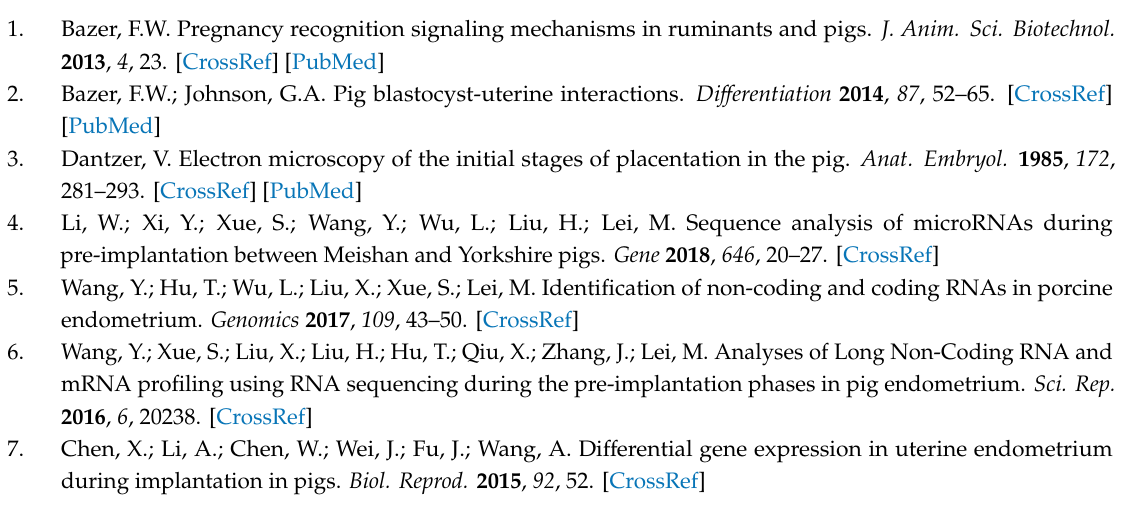
Table S1: Primer list of di ff erentially expressed genes and miRNAs validation, miRNA mimics sequences and scrambled sequence (NC) in dual luciferase reporter assays. Table S2: Raw data statistic of RNA-seq. Table S3: List of di ff erentially expressed genes between gestational days 12 and 15. Table S4: List of di ff erentially expressed genes between the two anatomical location (the mesometrial side and anti-mesometrial side of uterus). Table S5: List of di ff erentially expressed miRNAs between gestational days 12 and 15. Table S6: List of di ff erentially expressed miRNAs between the two anatomic location (the mesometrial side and anti-mesometrial side of the uterus). Figure S1: Validation of the predicted miR-142-3p-ITGB8 interactions with the dual luciferase reporter system. Author Contributions: All authors reviewed and approved the final version of the manuscript. M.Y. conceived and designed the experiments; J.H., Y.Y., and M.T. performed the experiments; J.H., D.D. and M.Y. analyzed the data; J.H. and M.Y. wrote and revised the